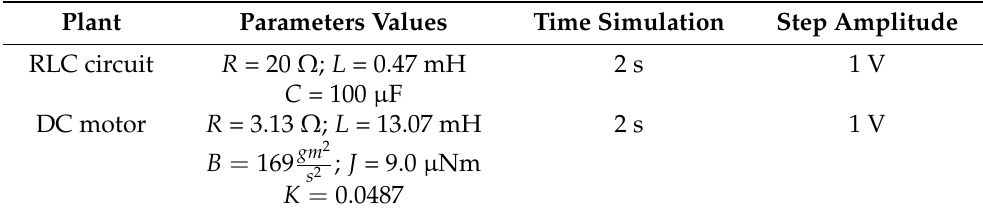
Table 6. Values used for simulate the